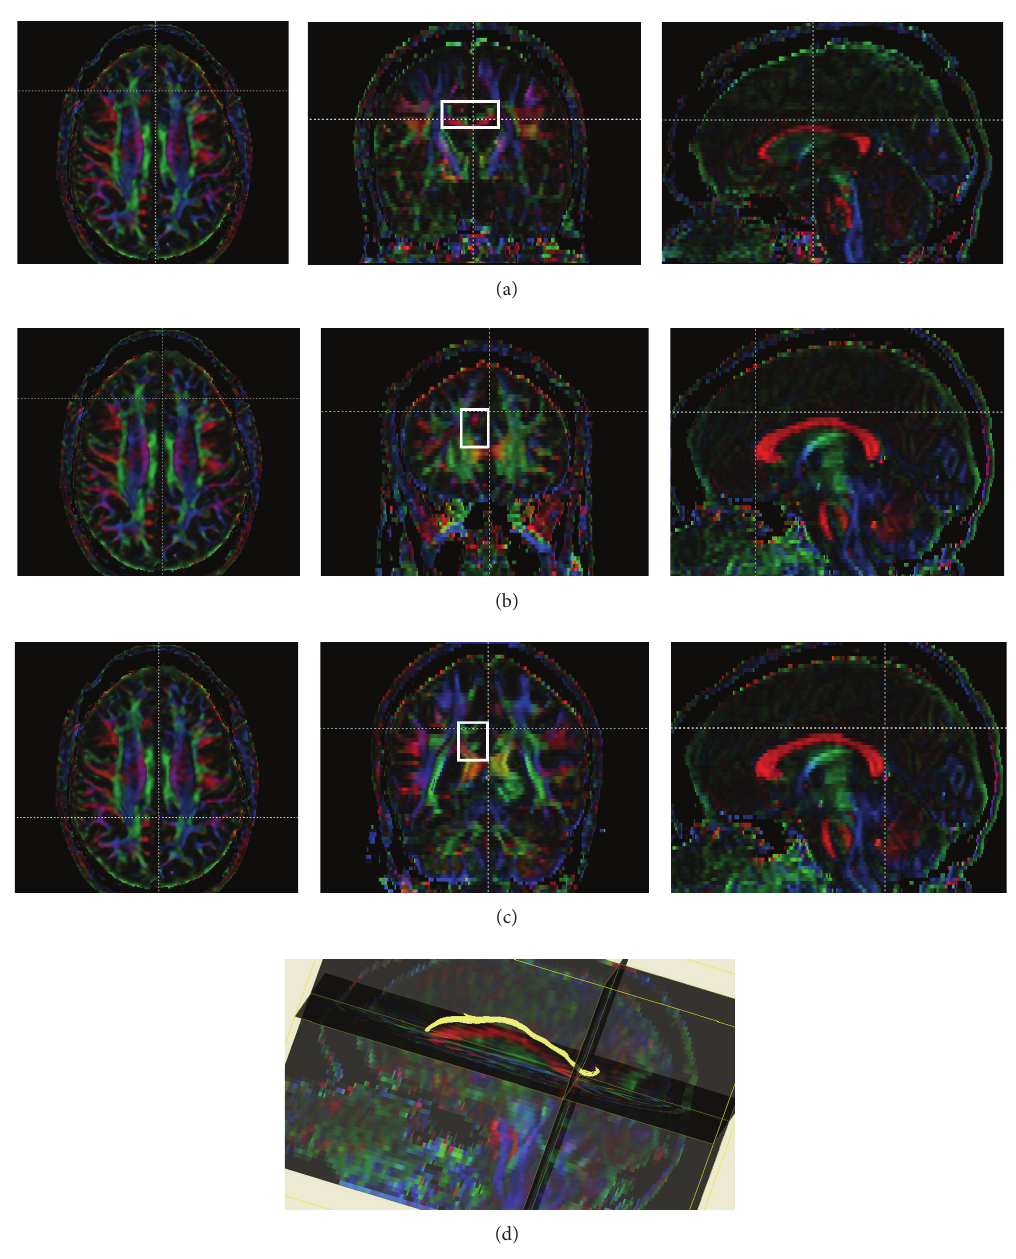
Figure 2: Tractography of the cingulum. Regions of interest were drawn on coronal sections. The first region was drawn on a coronal slice through the body of the corpus callosum, where cingulum fibers have an anteroposterior orientation (a). The second (b) and third (c) regions were drawn surrounding the area directly rostral to the corpus callosum at its anterior and posterior tips. The left and right cingula reconstructions were completed individually. Streamlines that passed through all three regions of interest were included in the study analysis and were terminated at the anterior and posterior regions. Three-dimensional reconstruction of the left cingulum in an MS case (d).